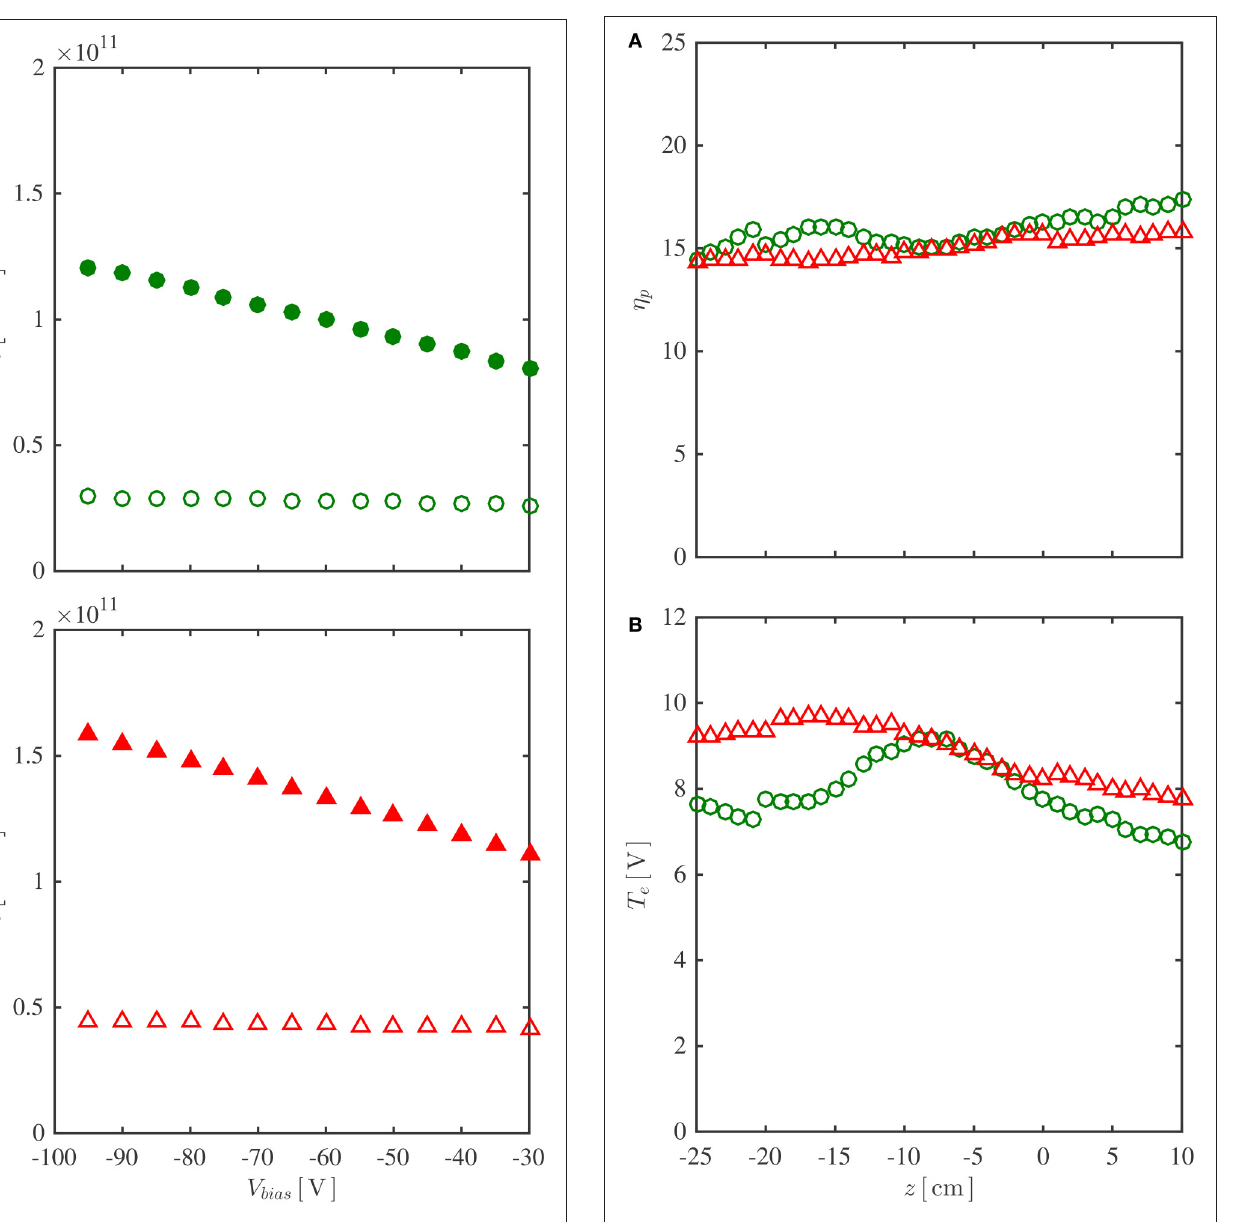
FIGURE 2 | Correlation data between ion density n i and biased voltage of LP V bias at z = − 9 cm, r = 0 cm, for (A) high field mode and (B) low field mode, using Sheridan’s method [Equation (2) and (3), open markers], and using the simplified method (Equation (1), solid markers).